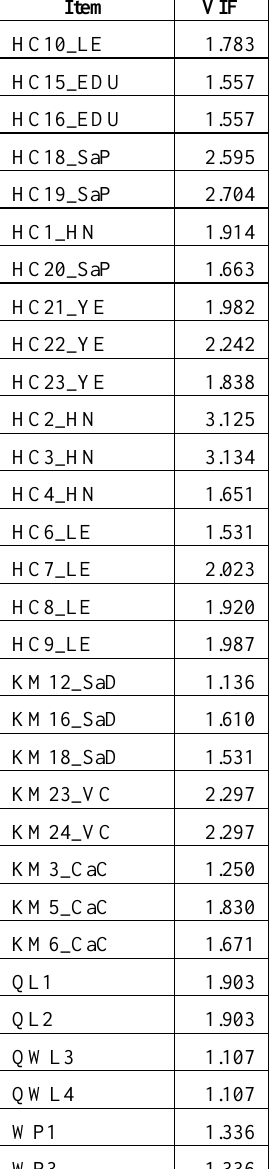
Composite Reliability